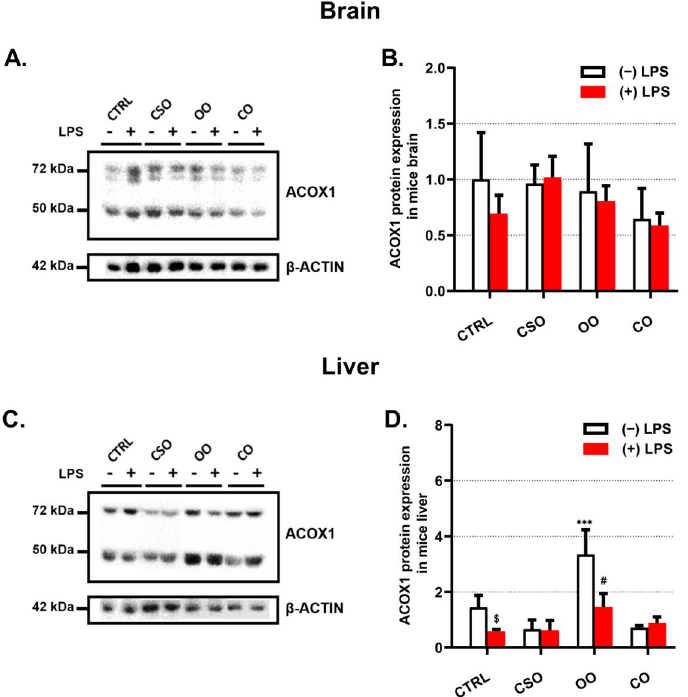
Figure 7. Effect of cactus seed oil, olive oil, or colza oil treatment on the expression of peroxisomal ACOX1 in brain ( A ) and in liver ( C ). Male C57BL/6 mice received for 28 days a standard diet (control (CTRL)), a diet enriched with 6% ( w / w ) CSO, OO, or CO, and intravenous injection of LPS (100 µg) four hours antemortem. Brain and liver homogenates were separated in PAGE-SDS electrophoresis and subjected to immunoblotting as described in Material and Methods section. Immunoblots were performed in triplicate and here we showed a representative blot. The ACOX1 72 and 52 kDa band intensities were analyzed by densitometry and standardized to β-actine (42 kDa) expression level in brain ( B ) and in liver ( D ). All values are means ± SD (n = 3) of 6 independent replicates for CTRL, LPS, CSO, and CSO+LPS, and 3 replicates for OO, OO+LPS, CO, and CO+LPS; statistical significance of higher mean signal strength (*** p ≤ 0.001) compared to control, (# p ≤ 0.05) compared to LPS, and ($ p ≤ 0.05) compared to the different treatments with or without LPS administration. Statistics were executed using two-way ANOVA followed by Tukey test for multiple comparisons.